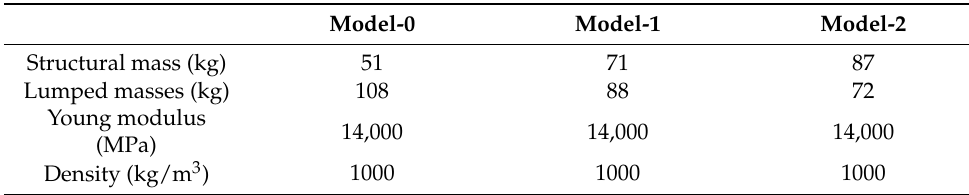
Table 1. The mechanical properties of each preliminary FE